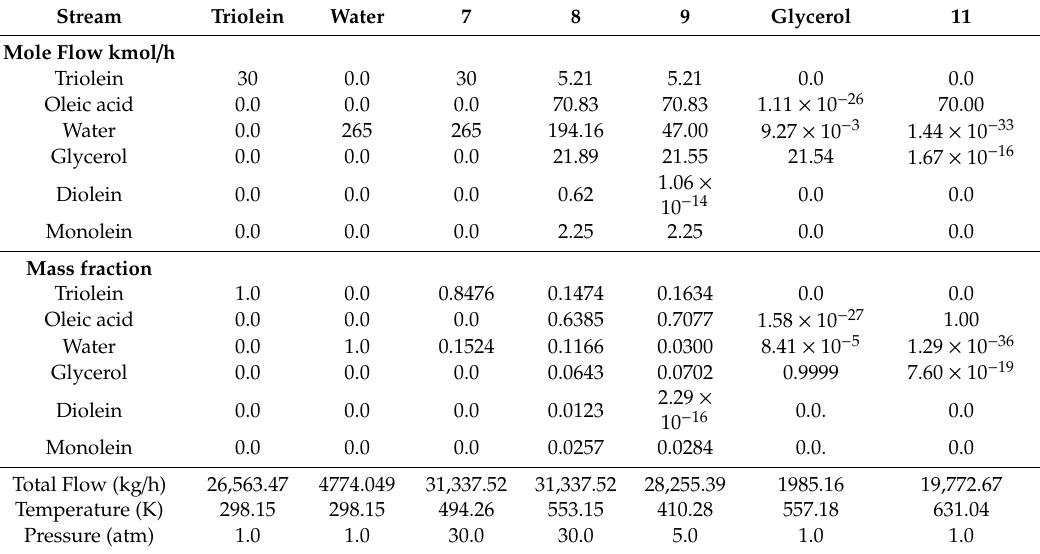
Table 2. Simulation results for the reference case (hydrolysis section).